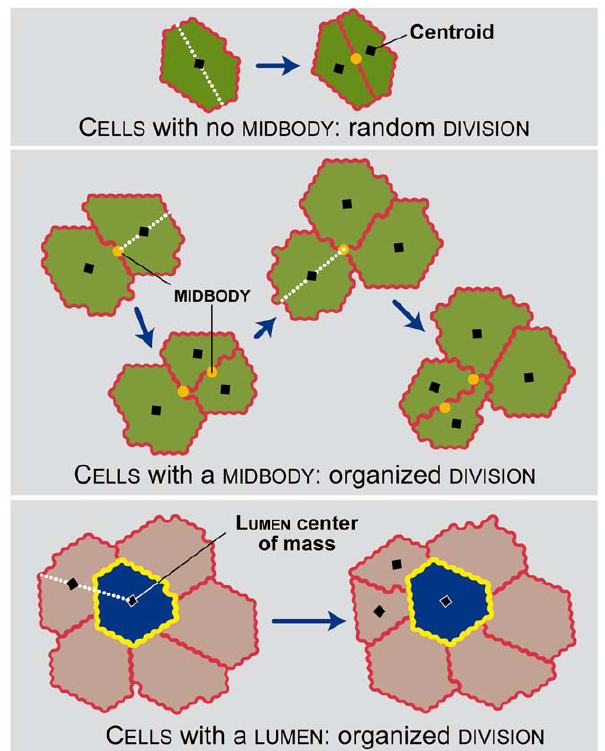
Figure 12. ISMA CELL DIVISION . C ELL DIVISION depends on the CELL neighborhood. Single isolated CELLS (top) that have not DIVIDED have no MIDBODY and DIVIDE with a random axis of DIVISION . When CELLS DIVIDE they find their centroid and store it as the MIDBODY of their daughter CELLS . C ELLS that have previously DIVIDED and have a MIDBODY utilize it for subsequent DIVISIONS . For these organized DIVISIONS (top), the axis of DIVISION is determined by a line drawn from a CELL ’s current centroid to the stored MIDBODY . C ELLS in contact with a LUMEN will also DIVIDE in an organized fashion (bottom), using a line between their centroid and that of the LUMEN to determine the axis of DIVISION . When the axis of DIVISION is determined, all points on one side of the line are assigned to a new CELL while all points on the other remain assigned to the original CELL .